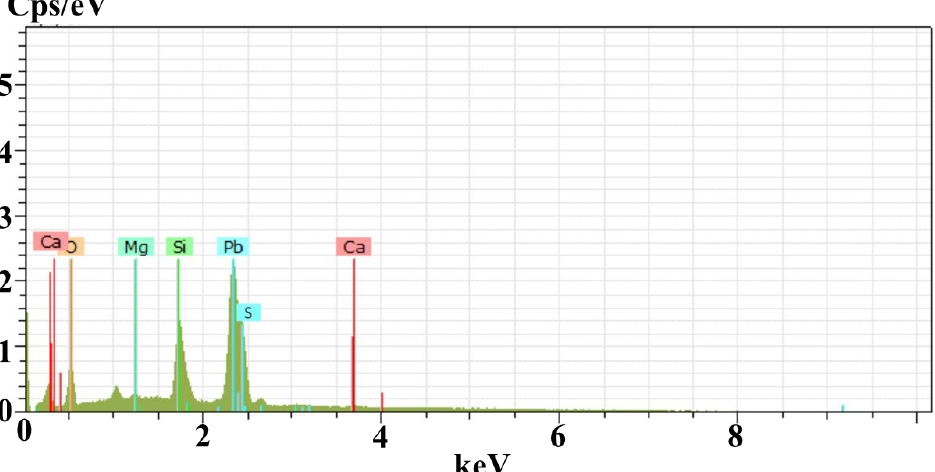
Figure 3. EDS spectra of PbS thin film of as-deposited sample. Table 1. Elemental concentrations determined by EDS of as-deposited PbS and annealed thin film at 200 °C, 300 °C, 400 °C, and 450 °C, respectively.